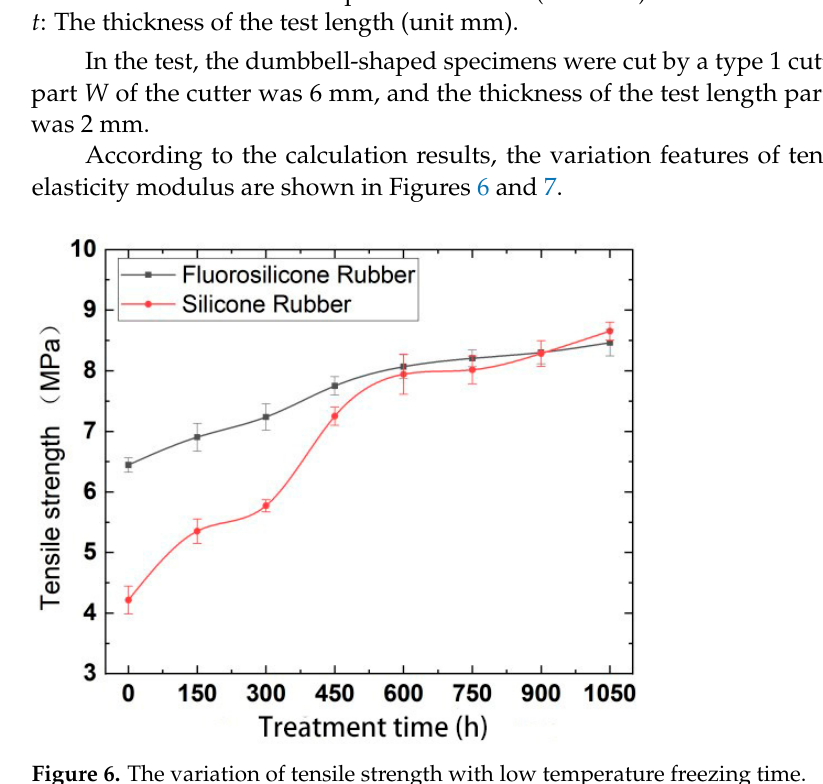
Figure 7. The variation of elasticity modulus with low temperature freezing time. Analysis of the above test results showed that the elastic modulus and tensile strength of the two samples increased with increase in low-temperature freezing time. The tensile property of the fluorosilicone rubber changed smoothly and its value was almost always higher than that of the silicone rubber, which indicated that the tensile strength of the fluorosilicone rubber was greater. After vulcanization, the rubber is crosslinked into a random network structure. In addition to the influence of intramolecular chemical bonds, tensile strength is also related to the physical crosslinking and intermolecular forces between molecules. When the rub- ber is stretched, the intermolecular force is first broken, and then the stress is concentrated on the oriented main chain, and physical crosslinking and chemical bond breakage occur [27]. The molecule chain structure is the main factor determining the basic properties of polymers, and the aggregation structure is the main factor determining the bulk proper- ties of polymers. Therefore, the aggregation morphology of molecular chains has a great influence on the performance of silicone rubber, while the main factor affecting the aggre- gation morphology of molecular chains in silicone rubber is temperature [28]. With in- crease in freezing time, the thermal motion energy of polysilane molecular chains de- creases, and the activity of the motion units also decreases, reflecting the volume shrink- age effect of polysiloxane molecular chains at low temperature. That is, with decrease in 0